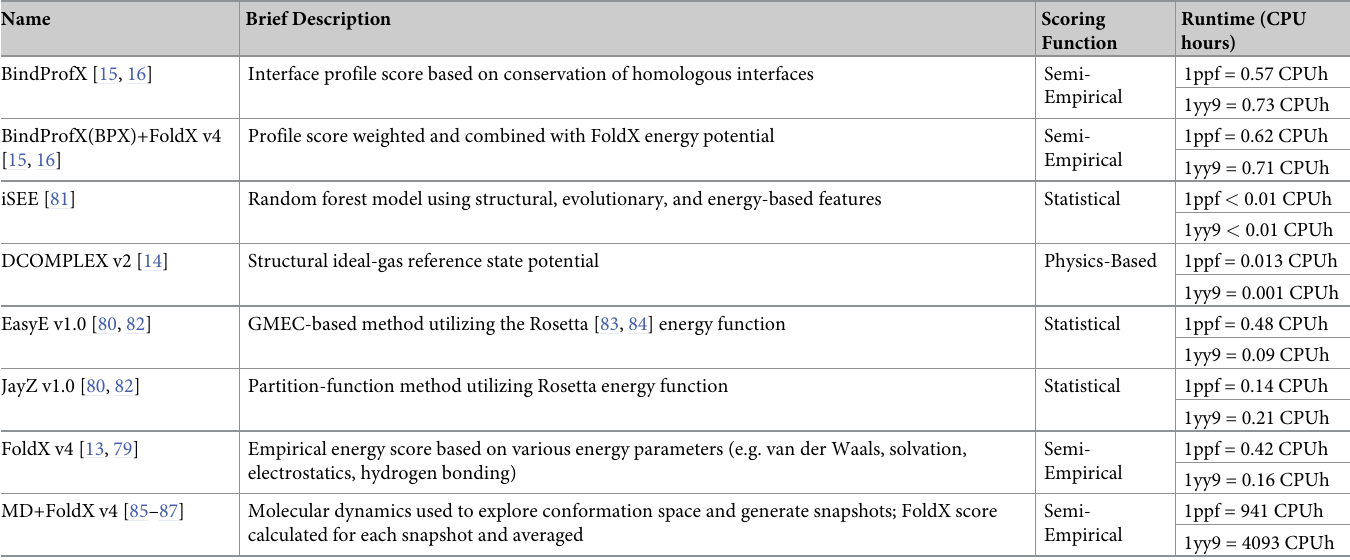
Table 2. Methods used for comparison in study with a short summary of their approach and scoring